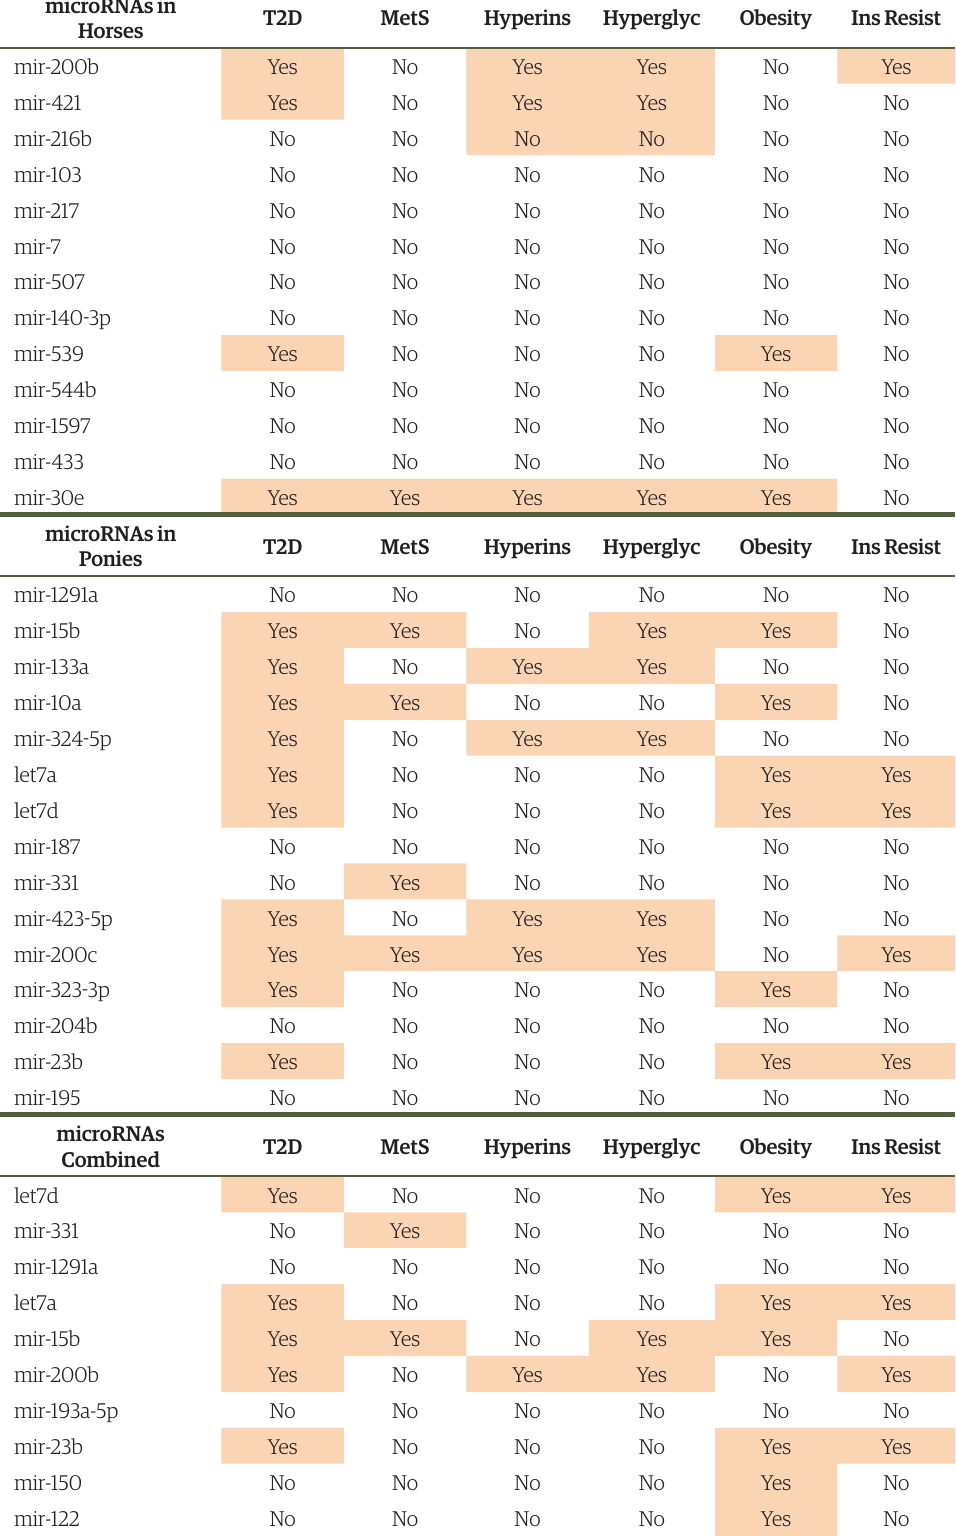
Table 7. Significantly different microRNA and their associated diseases, in mouse. DIANNA Pathway analysis.